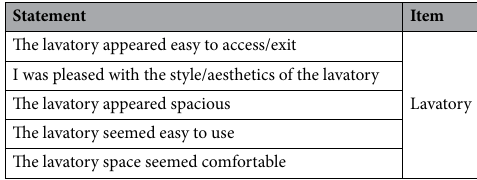
Table 5. Lavatory scenario questionnaire.